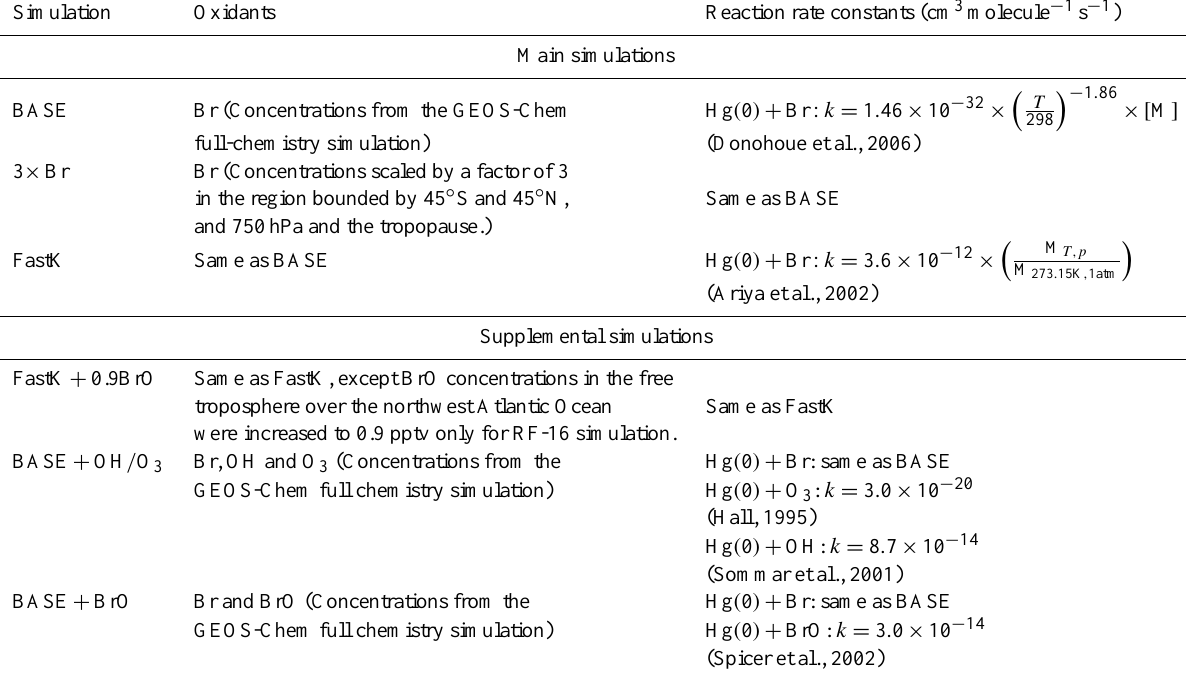
Table 2. Summary of GEOS-Chem simulations performed for this